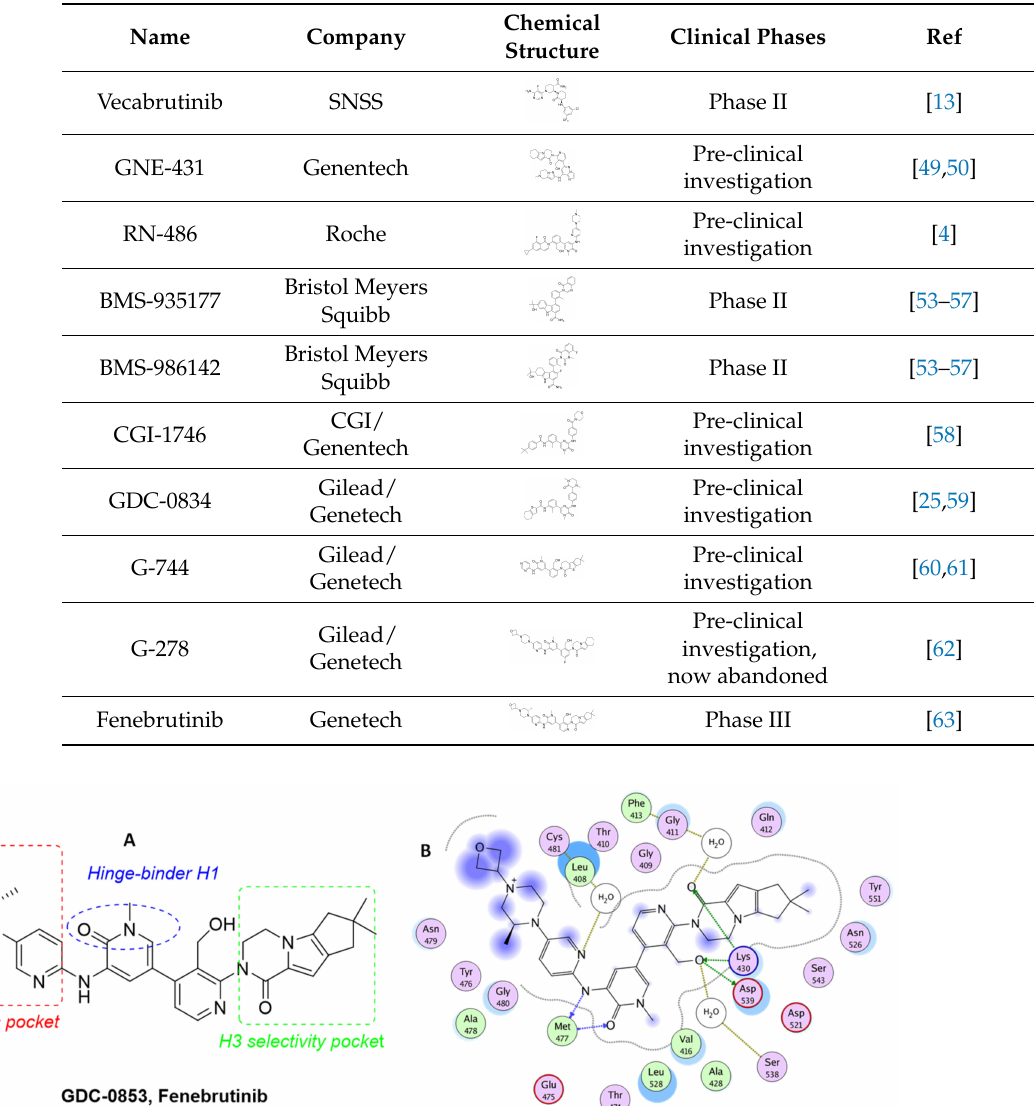
Table 3. Name, chemical structure of some reversible BTKIs under clinical or pre-clinical investigations.